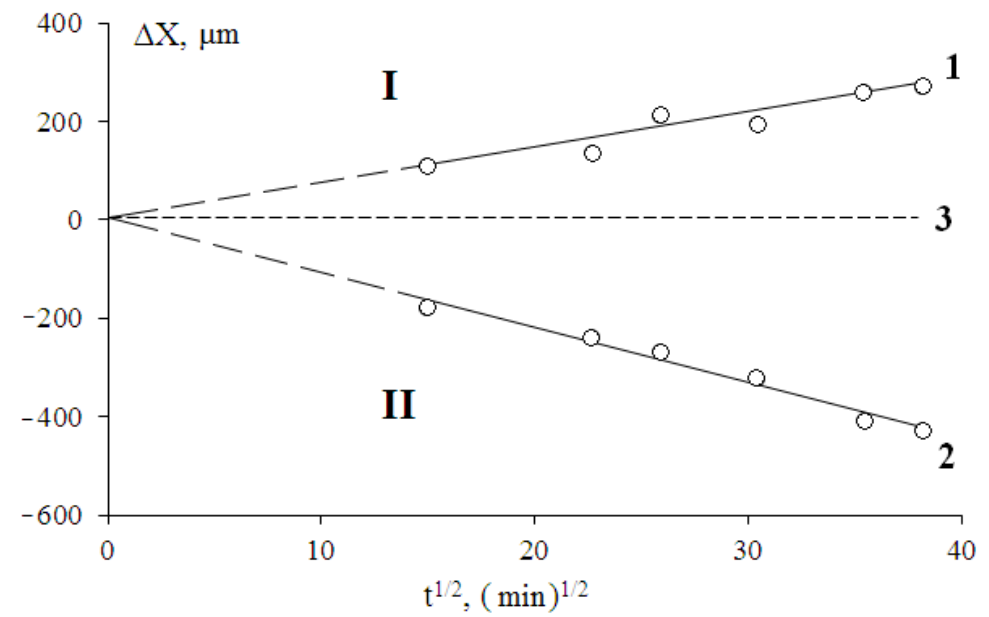
Figure 9. Kinetic dependences of fronts movement in the LLDPE–HDPE-2 system at 160 °C. I—zone of diffusion of low molecular weight HDPE-1 into the LLDPE phase (1), II—zone of diffusion of LLDPE into the HDPE-2 phase (2), 3—coordinate of phase conjugation site at the initial time.